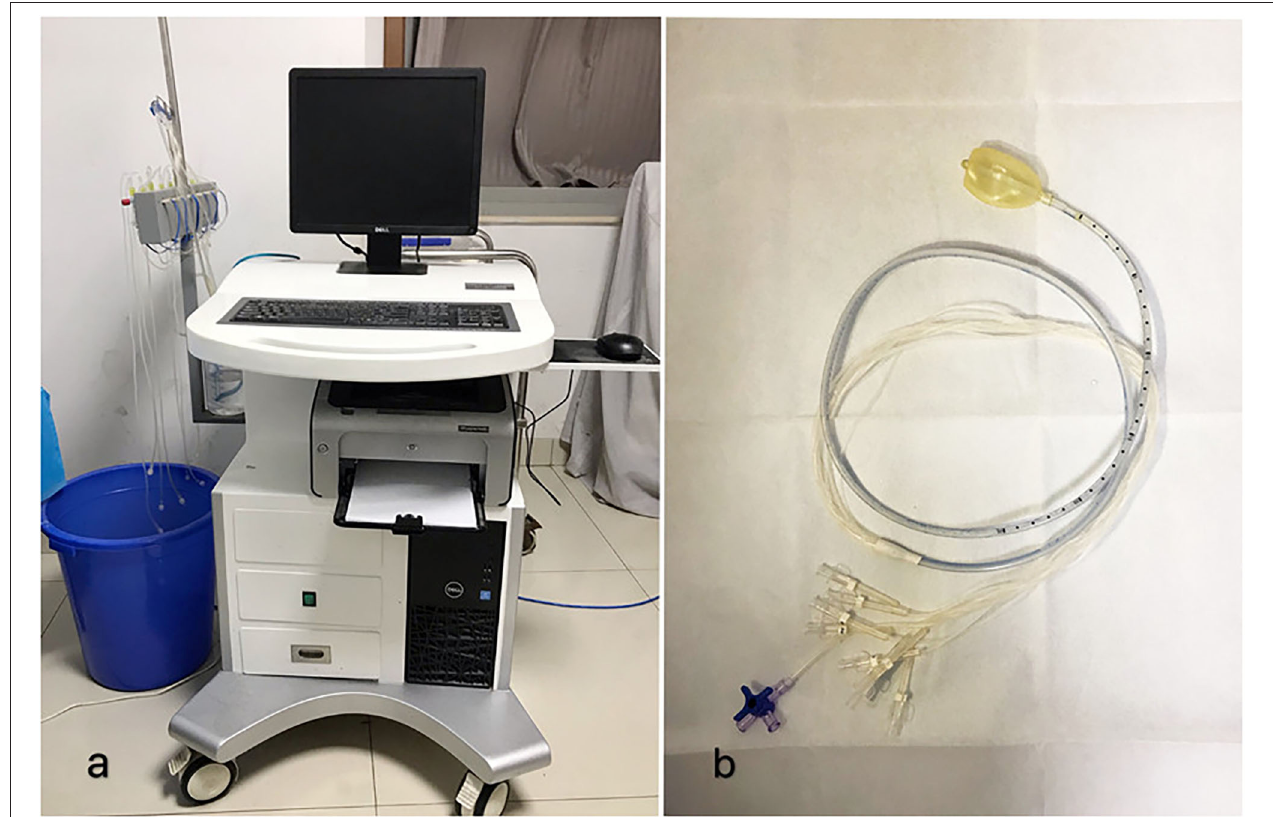
FIGURE 2 | (a) The biofeedback instrument (XDJ-S8G, KaiLi, HeFei, AnHui, China). (b) The BFT catheter.